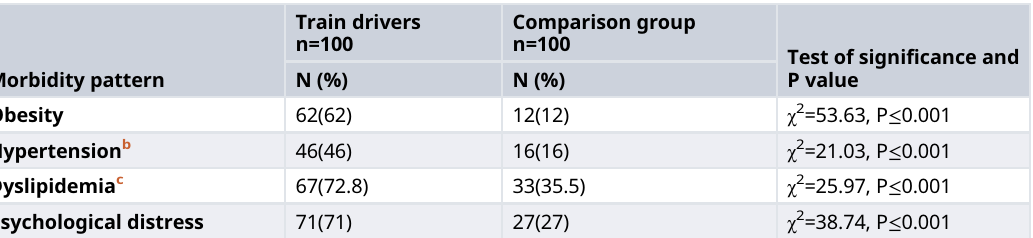
Table 3. Morbidity pattern of the study groups.